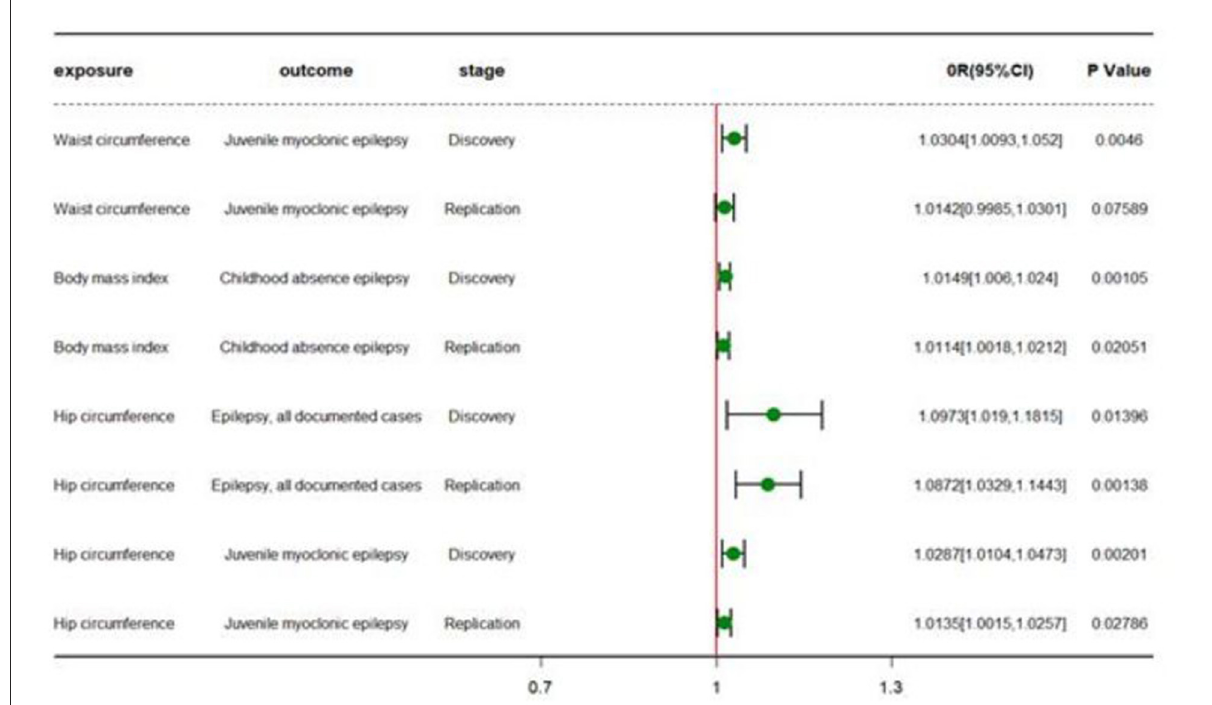
FIGURE2 Forest plot of different TSMR stages. OR (95%CI) is the odds ratio of each MR estimate. P -value is the significant level of each MR